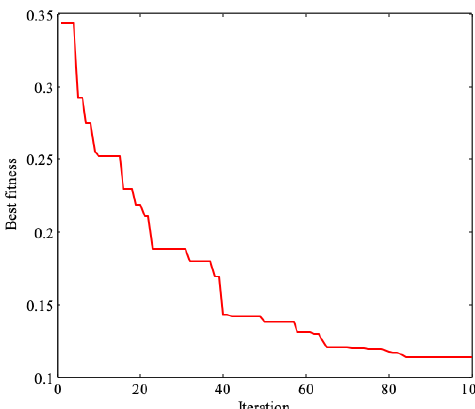
Figure 4. Optimization process.